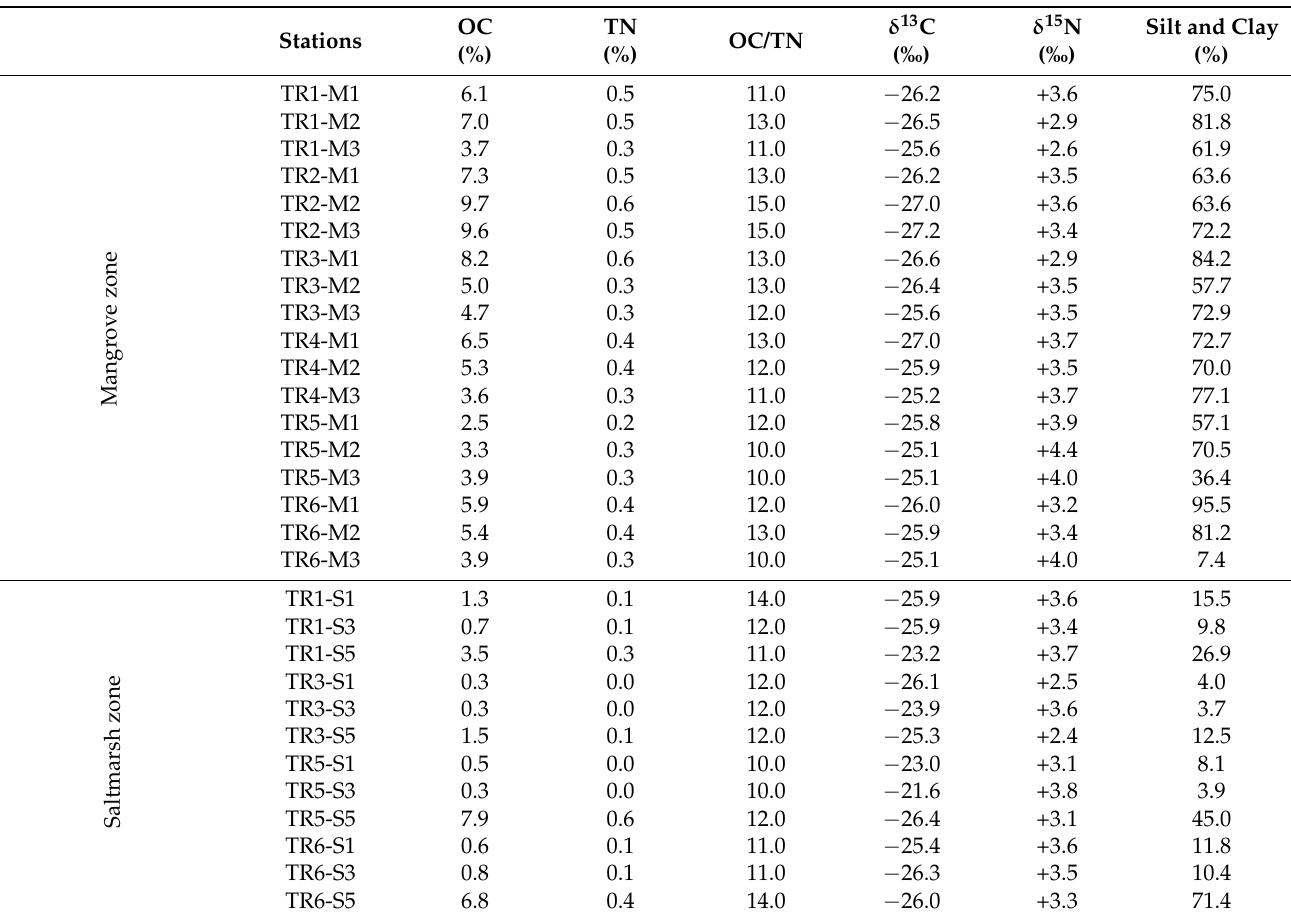
Table 1. Distribution of OC (%), TN (%), OC/TN (molar ratio, δ 13 C (‰), δ 15 N (‰), silt and clay (%) in surficial sediments of mangroves and the adjacent saltmarsh